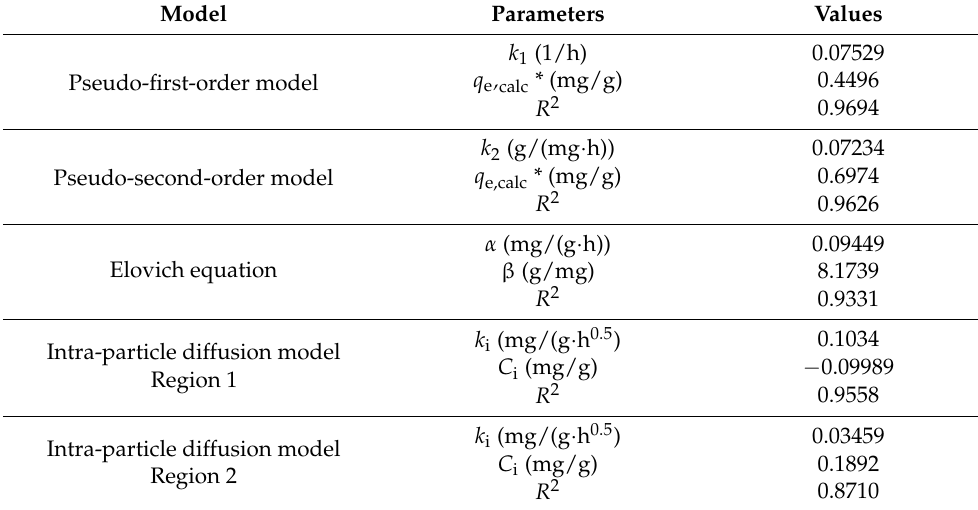
Table 3. Fitted kinetic parameters of pseudo-first-order, pseudo-second-order, Elovich, and intra- particle diffusion models for adsorption of Cr(III) ions onto the Cr(III)-IIM at concentration 5 mg/L, pH 6, temperature 40 ◦ C, and adsorbent dose (one membrane) 0.140 g. Model Parameters Values Pseudo-first-order